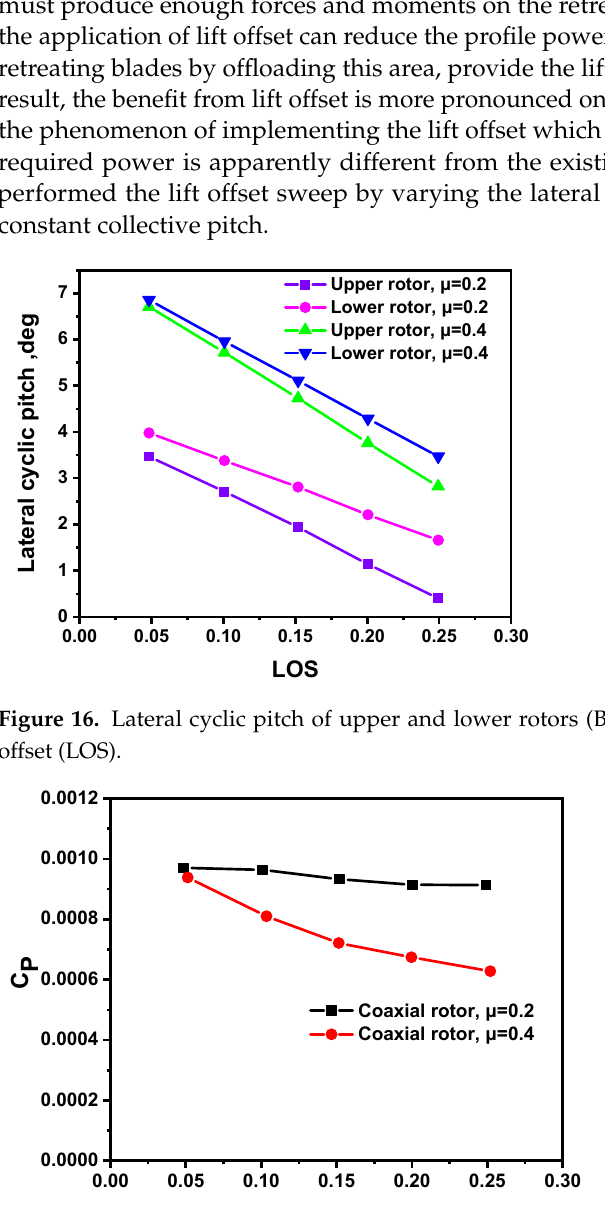
Figure 17. Power coefficient (C P ) as a function of the lift offset (LOS).